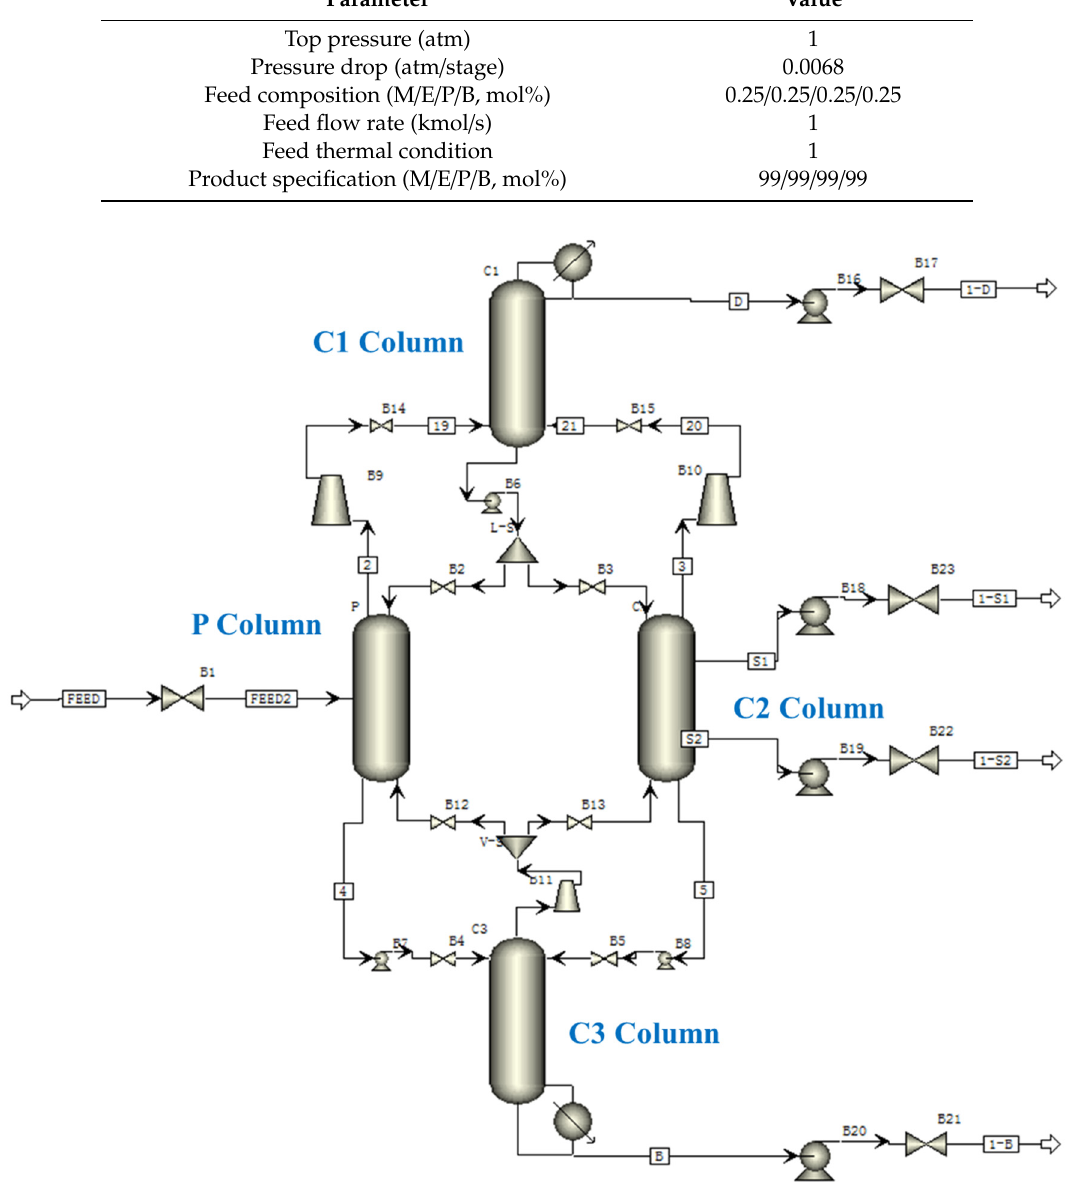
Figure 4. Kaibel distillation column model built in Aspen Plus.